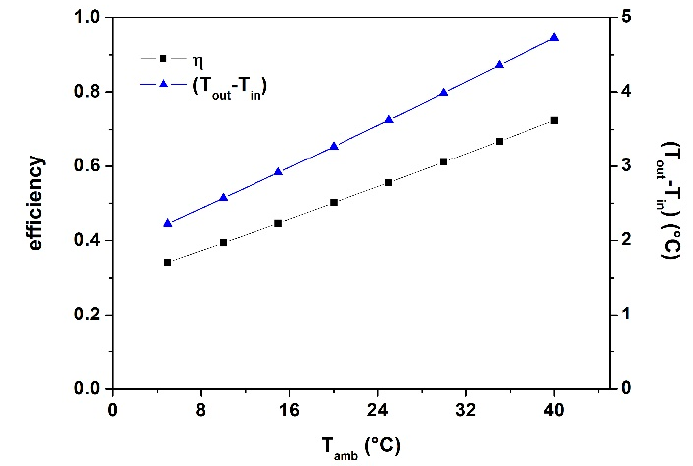
Figure 11. Results of the parametric study. Efficiency and temperature difference vs. ambient temperature.